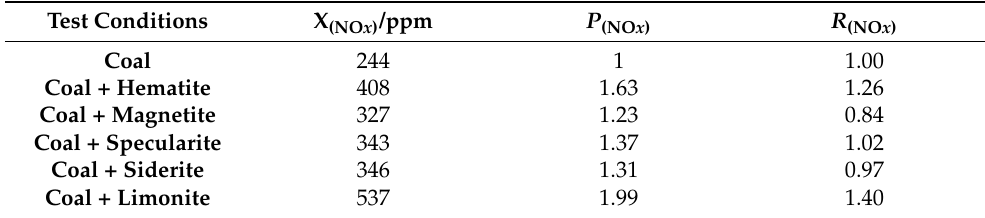
Figure 7. Effects of iron-bearing pure minerals on P (NO x ) and R (NO x ) during pulverized coal combustion. Table 5. Effects of iron-bearing pure minerals on X (NO x ) , P (NO x ) and R (NO x) during pulverized coal combustion (minus the amount of NO x produced by the iron-bearing pure